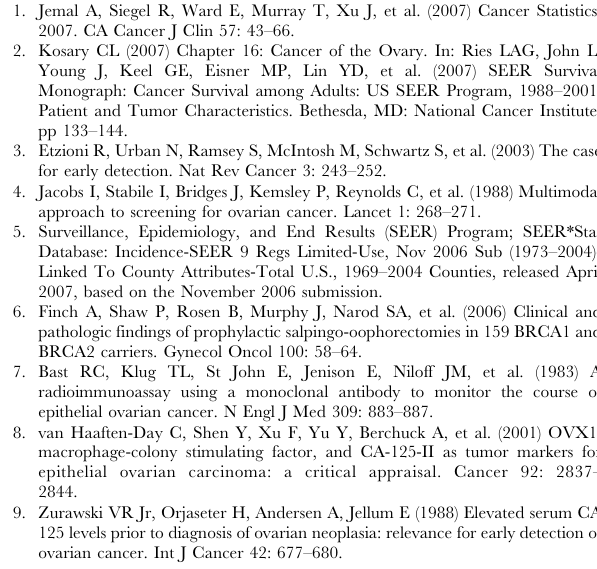
Table S2 Detailed assay characteristics and conditions for commercial